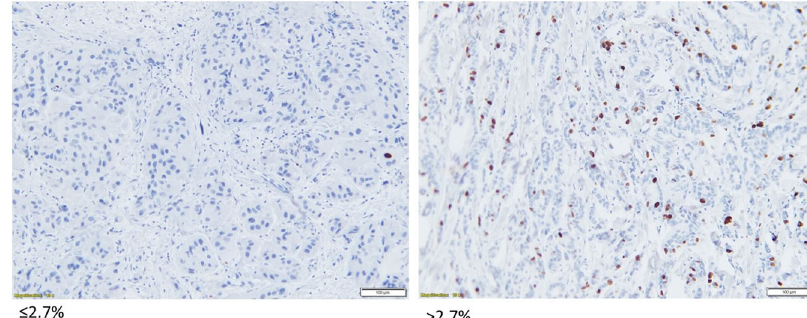
Fig. 3 Image of tumor sample with Ki67 scoring of ≤ 2.7% and >2.7% by immunohistochemistry (IHC).